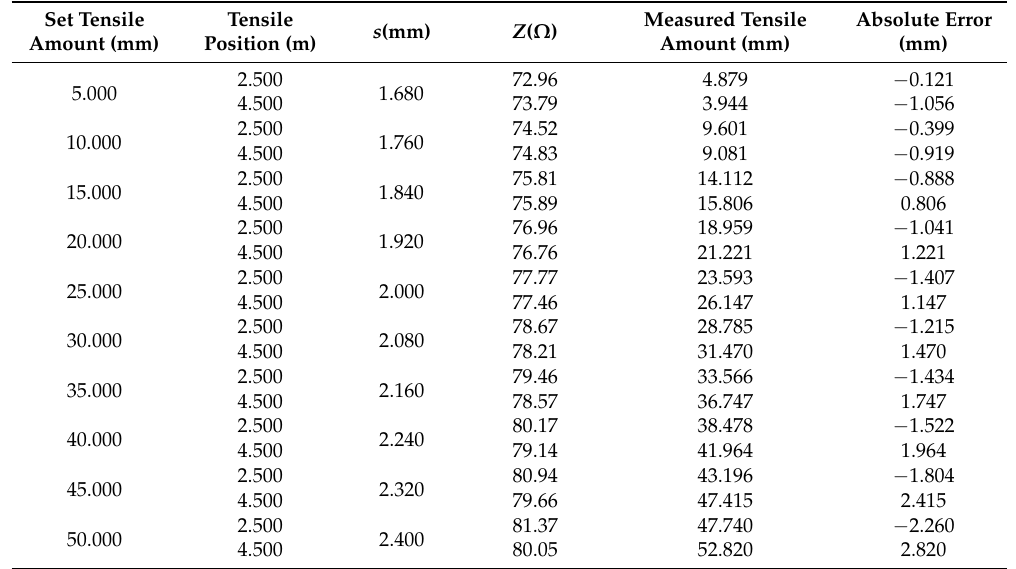
Table 4. The measured results at the 2.5 and 4.5 m